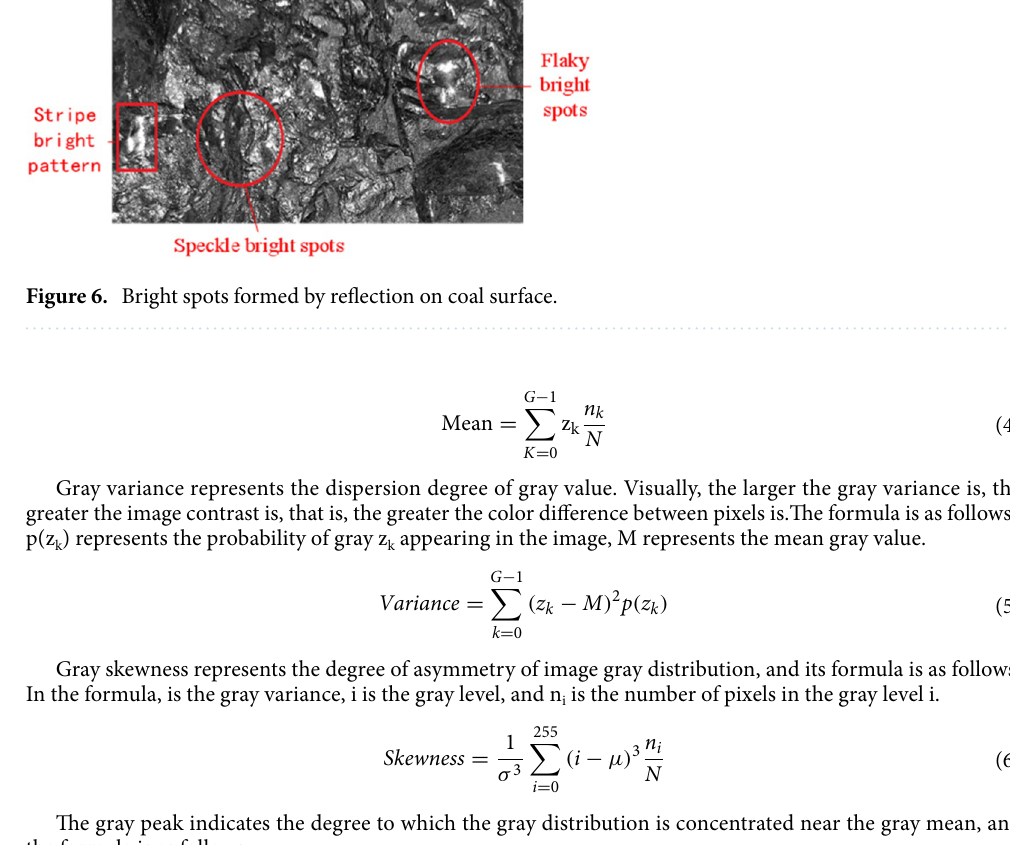
Gray energy represents the uniformity of image distribution, and its formula is as follows.